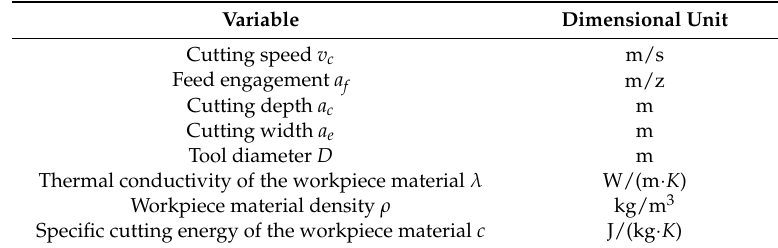
Table 4. Dimensional analysis of the factors that affect the average temperature in the tool-chip contact area.